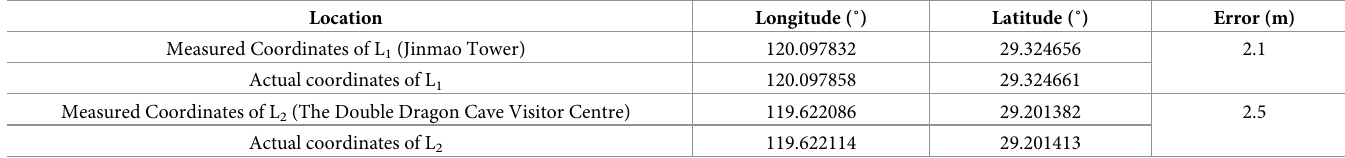
Table 2. Comparison of positioning errors between L 1 and L 2